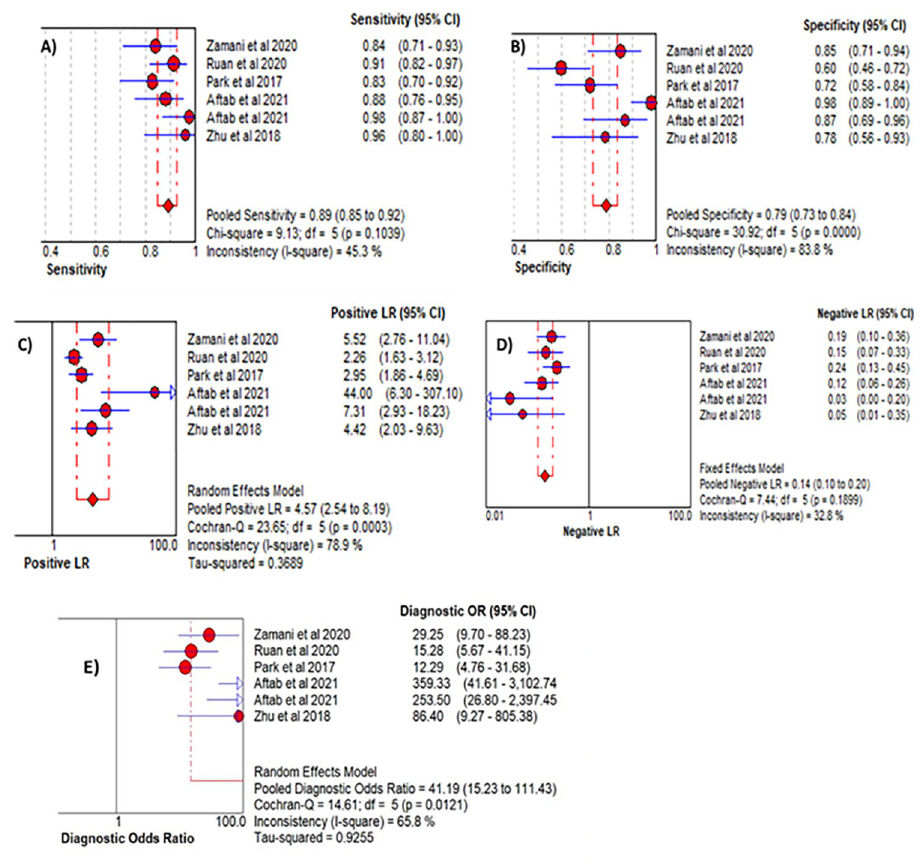
Fig 5. Forest plots depicting the pooled sensitivity, specificity, PLR, NLR, and DOR of microRNA-21 assay diagnostic value in cervical cancer (LR: Likelihood ratio; OR: odds ratio; CI: confidence interval).